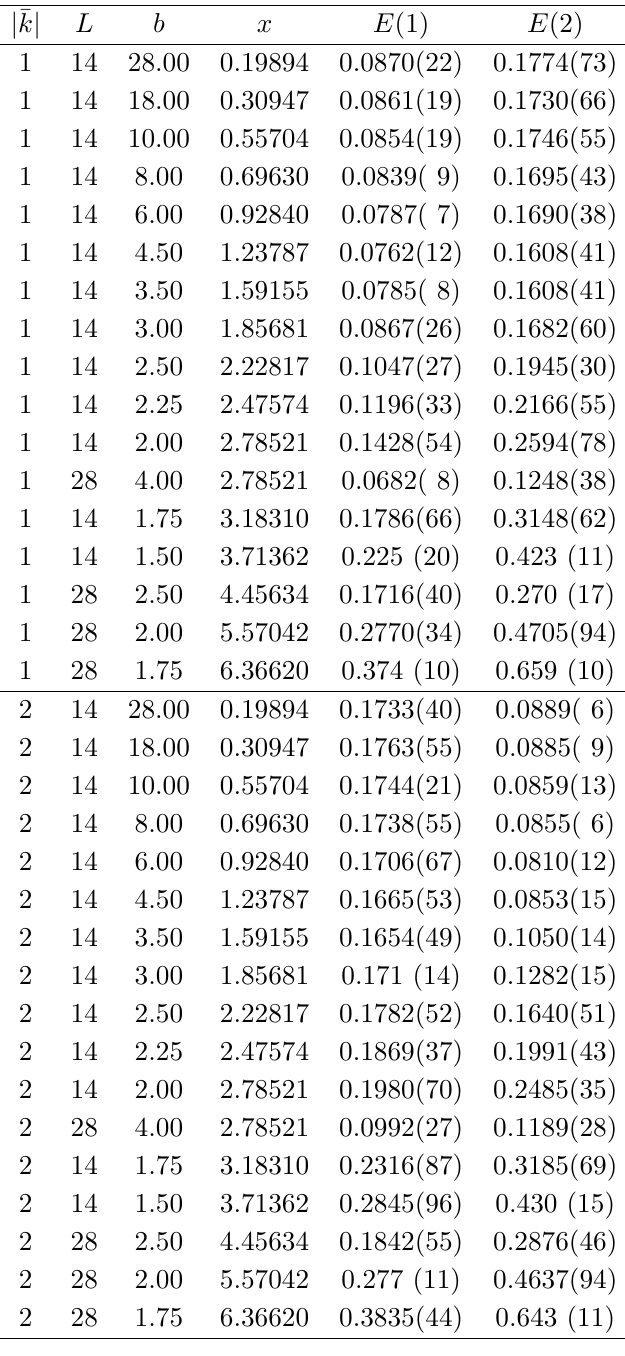
Table 3. SU(5) torelon energies (in lattice units). The states are labeled by the value of the electric (cid:13)ux modulus E ( j ~e j